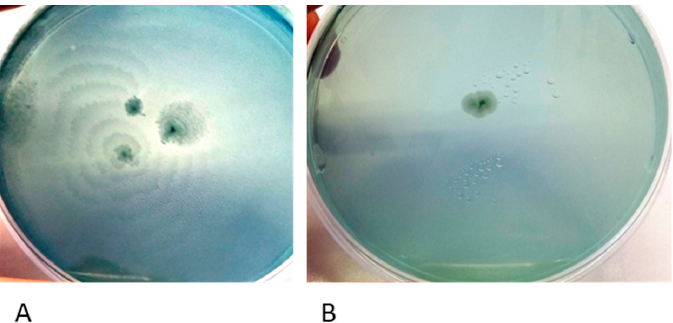
Figure 2. Swarming of PM1 ( A ); and PM2 ( B ) on Cystine Lactose Electrolyte Deficient (CLED) agar plates.